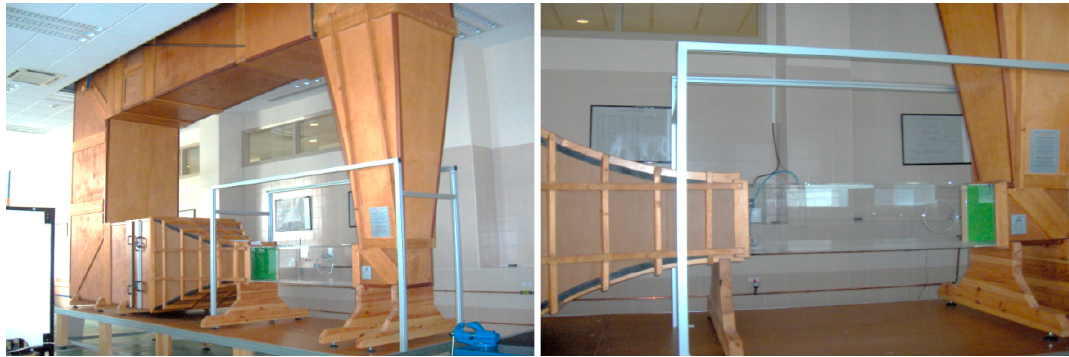
Figure 3. Wind tunnel used in the present study.